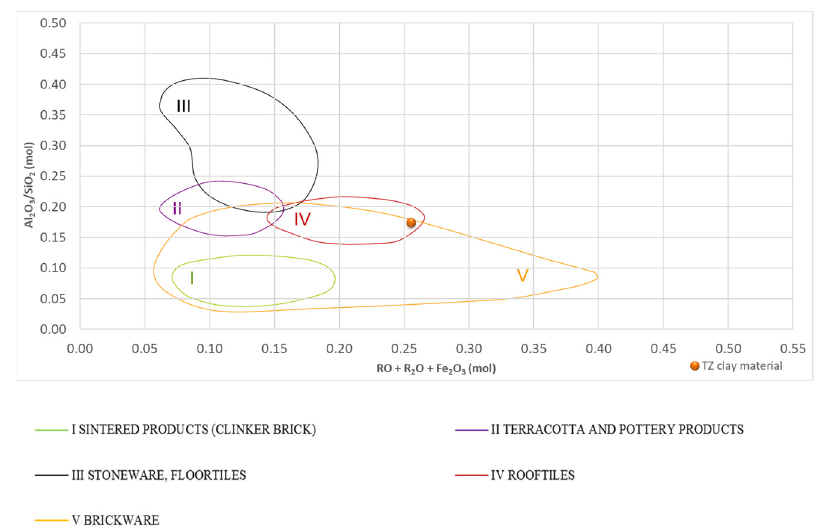
Figure 2. Suitability according AVGUSTINIK of TZ clay.